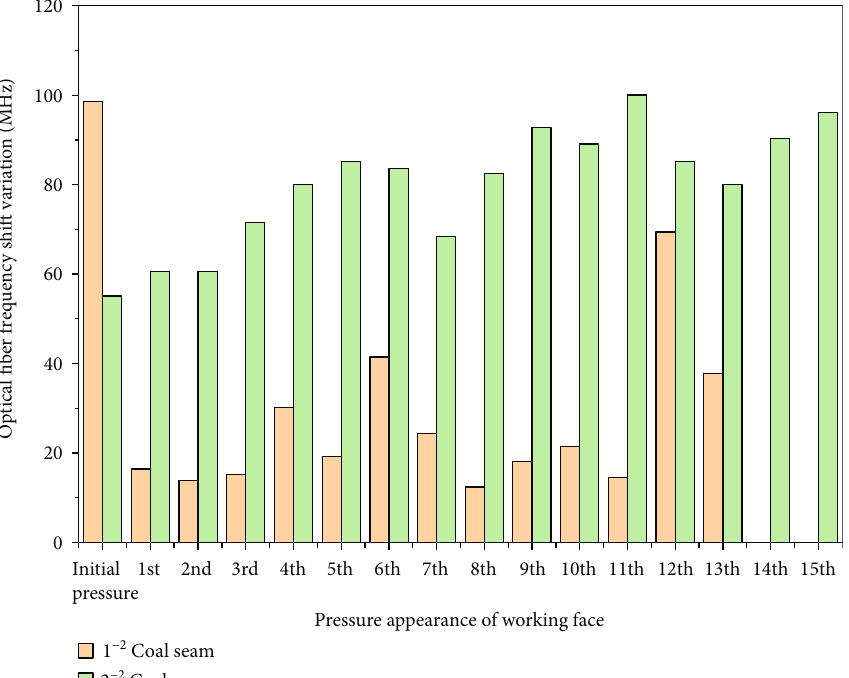
Figure 10: Comparison of the variation degree of the optical fi ber frequency shift with the impact pressure (the ordinate is peak values in the mining of coal seams 1 -2 and 2 -2